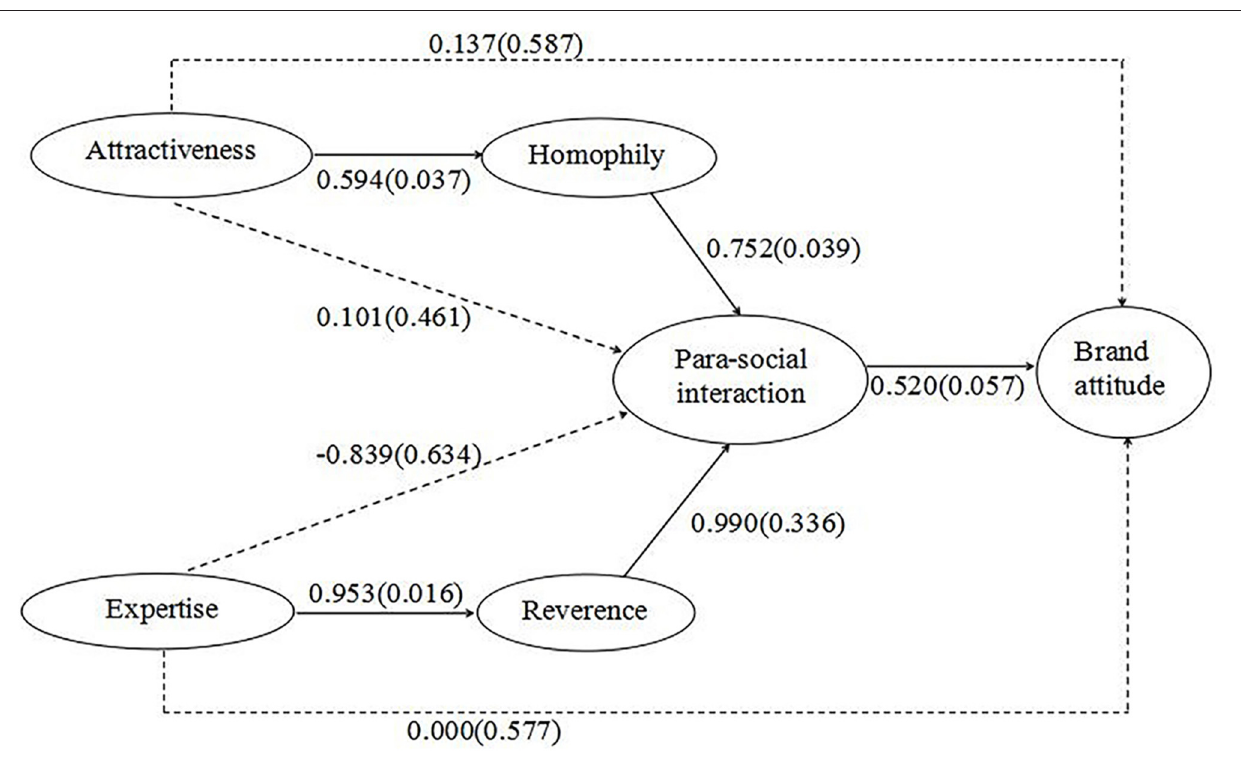
FIGURE 2 | Statistical model of the endorsement path. The standardized coefficients (with stand error in parentheses) of the solid paths are significant at p , 0.01; Model fit: Chi-square value X ² (550), 1252.503, RMSEA, 0.050, CFI, 0.909, TLI, 0.902, SRMR,